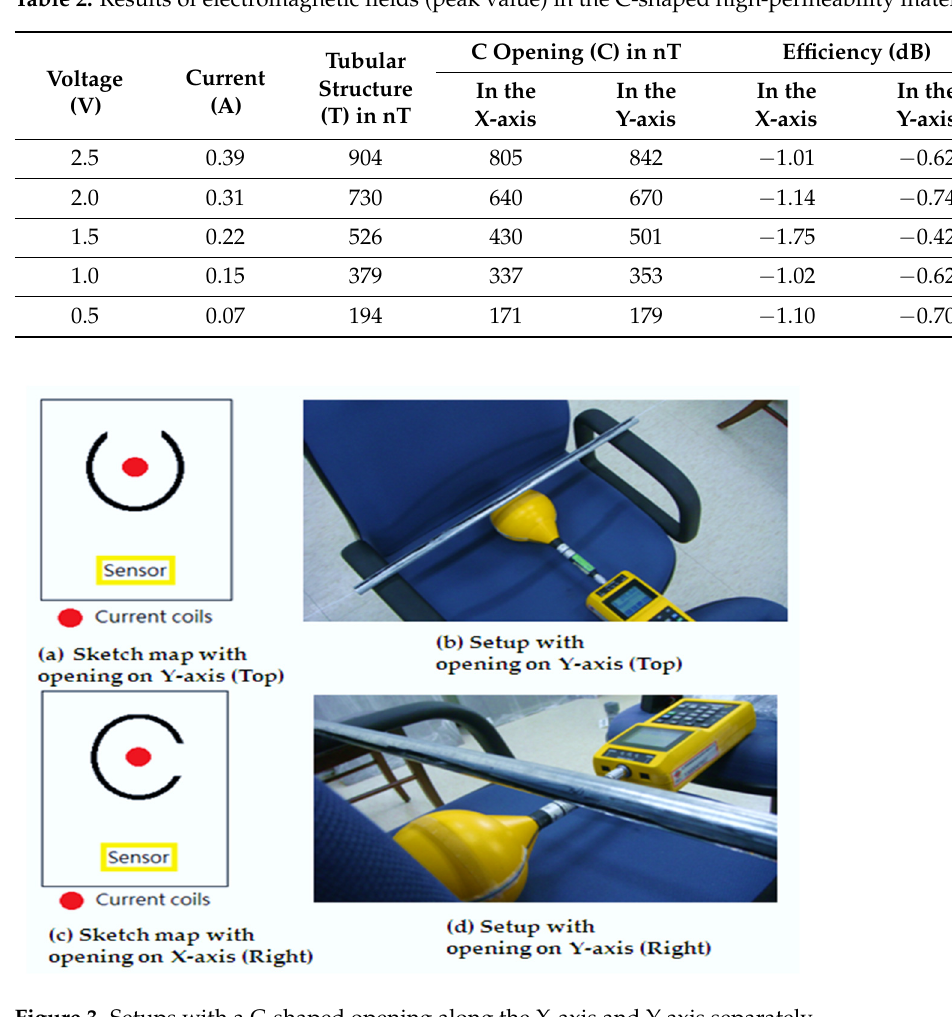
Figure 3. Setups with a C-shaped opening along the X -axis and Y -axis separately.